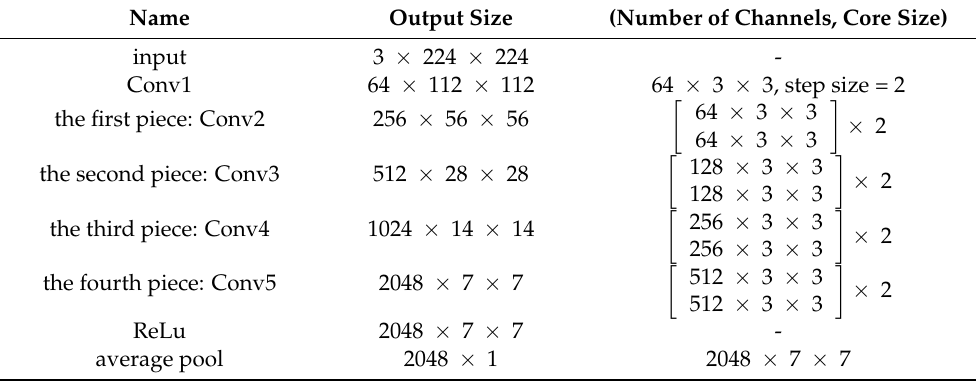
Table 2. Model parameters of ResNet18.